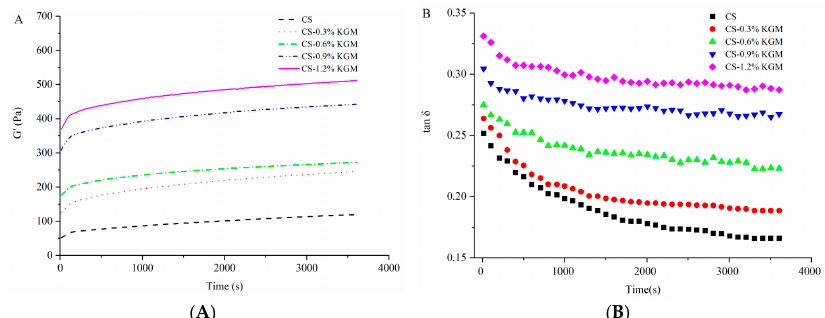
Figure 3. Curves of storage modulus ( A ) and tan δ ( B ) with time of CS/KGM mixtures.